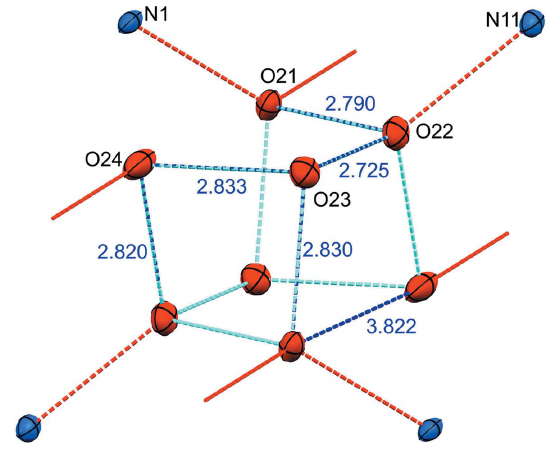
Figure 5 Pseudo-cubic arrangement ( C i symmetry) of the oxygen atoms of the water molecules inside the channel at 100 K. The red dotted lines indicate the hydrogen bonding to the nitrogen atoms of the TMP walls and to the oxygen atoms in neighbouring octamers along the